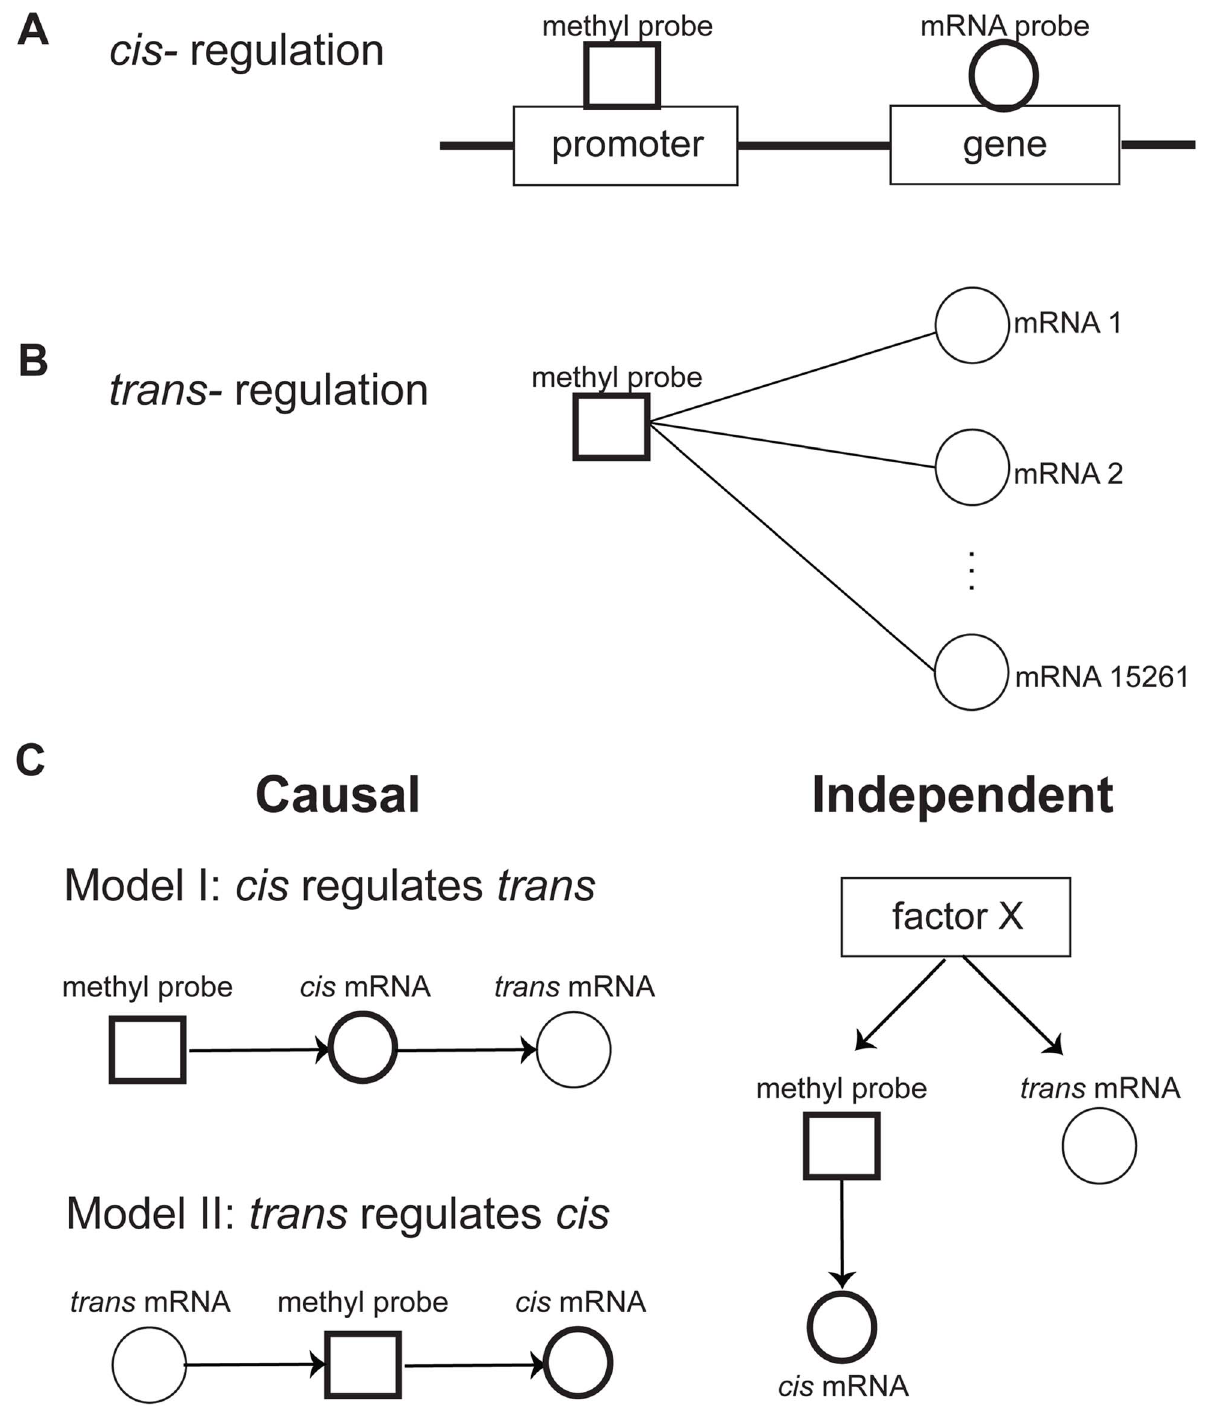
Fig. 1. Relationships between DNA methylation and gene expression. A ) Cis regulation was defined by the correlation of the methylation level at the promoter region of a gene with expression level of the gene. B ) Trans regulation was defined by the correlation of a methylation level at the promoter region of a gene with expression level of other genes. C ) Potential relationships between cis and trans regulations. There are two potential causal mechanisms of cis and trans connections: Model I, where the methylation level regulates trans gene expression via the cis gene expression, and Model II, where Trans gene expression regulates the cis gene via controlling its methylation level. It is also possible that cis and trans connections are independently regulated by a factor X.